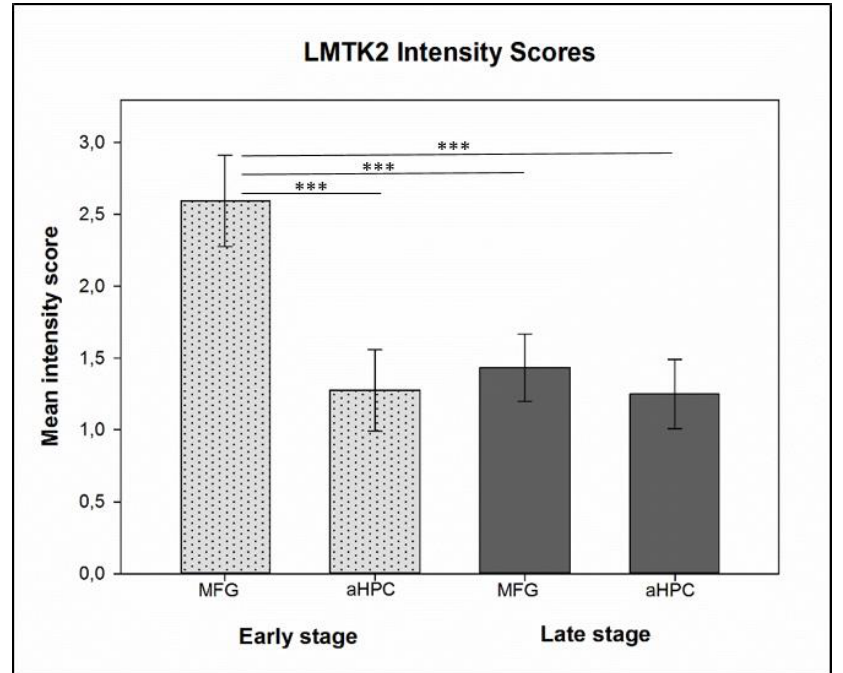
Figure 2. Histogram depicts the mean chromogenic lemur tyrosine kinase 2 (LMTK2) intensity scores in the middle frontal gyrus (MFG) and anterior hippocampus (aHPC) brain regions in early (dotted light gray columns) and late (dark gray columns) neuropathological Braak tau stage cases. Here, t -test showed statistically significant ( p < 0.001 (***)) differences between pairwise comparison of the mean intensity scores of early neuropathological stage MFG group (endogenous control — spared from neurofibrillary tangles (NFTs)) vs. NFT-affected groups (aHPC in early neuropathological stage and both regions in late neuropathological stage).